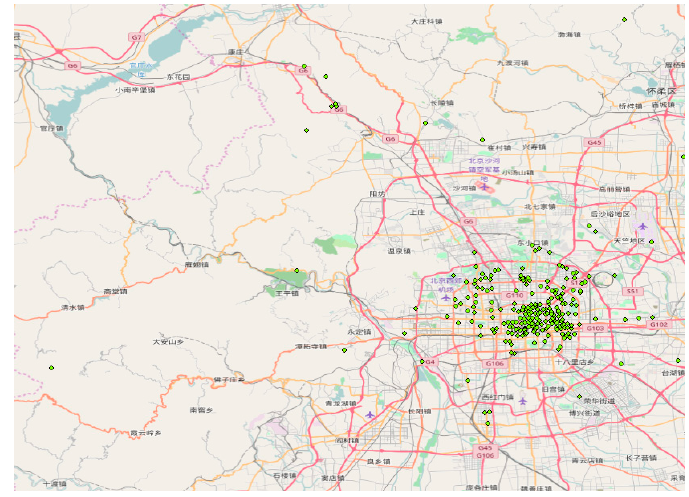
Figure 4. Cluster center distribution map after tourist attraction discovering.